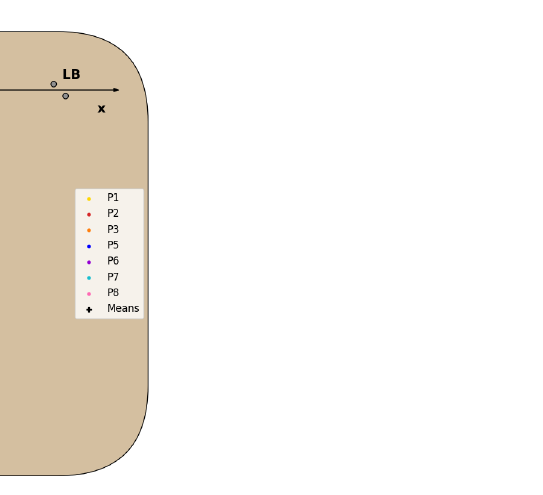
Figure 7. Diagram of the dataset of CM coordinates for each evaluated sitting position, except P4, and corresponding